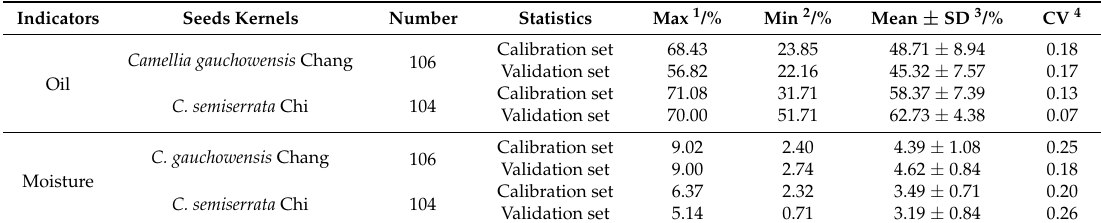
Table 1. Calibration and validation statics in NIRS models for the estimation of oil and moisture